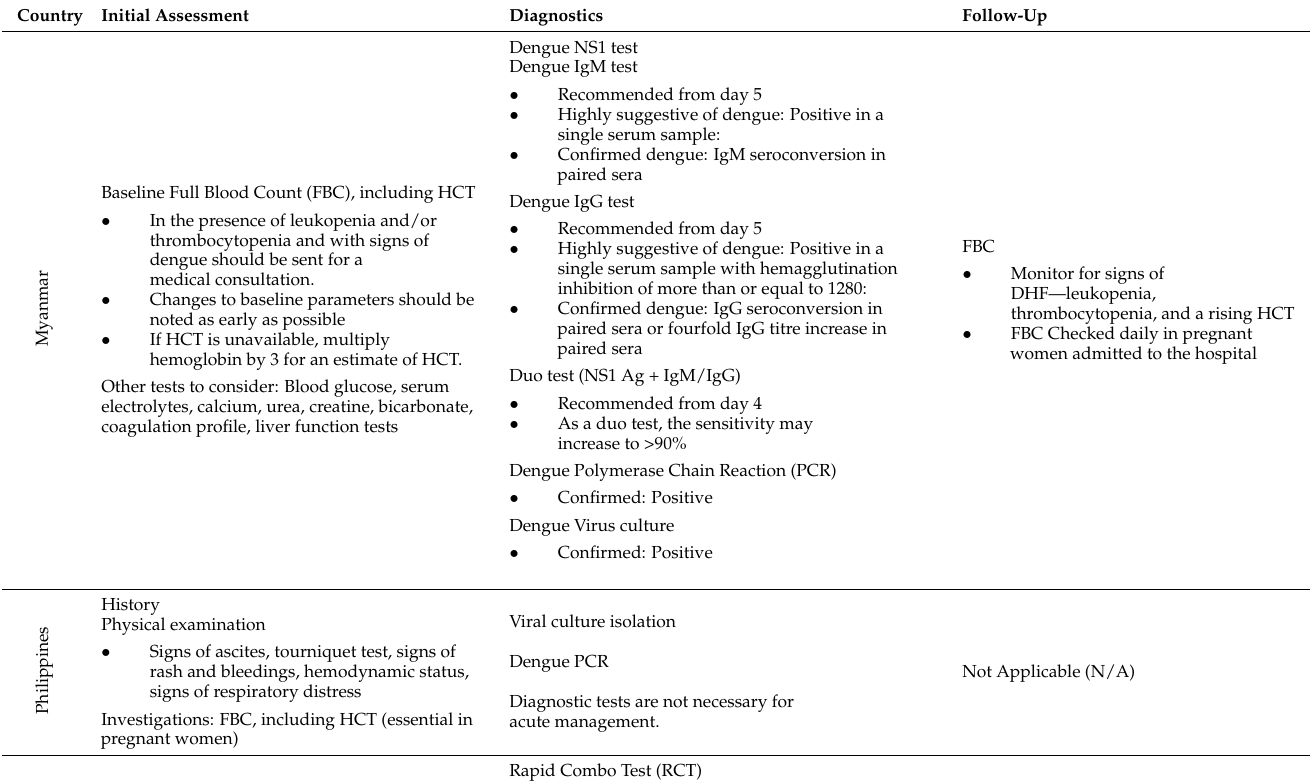
Table 7. Comparison of investigations recommended by dengue guidelines from Myanmar [101], the Philippines [100], Malaysia [5], Thailand [91], and Singapore